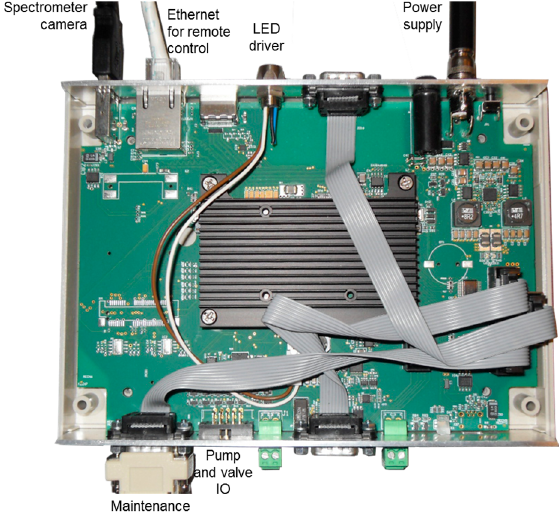
Figure 10. The main controller mother board.